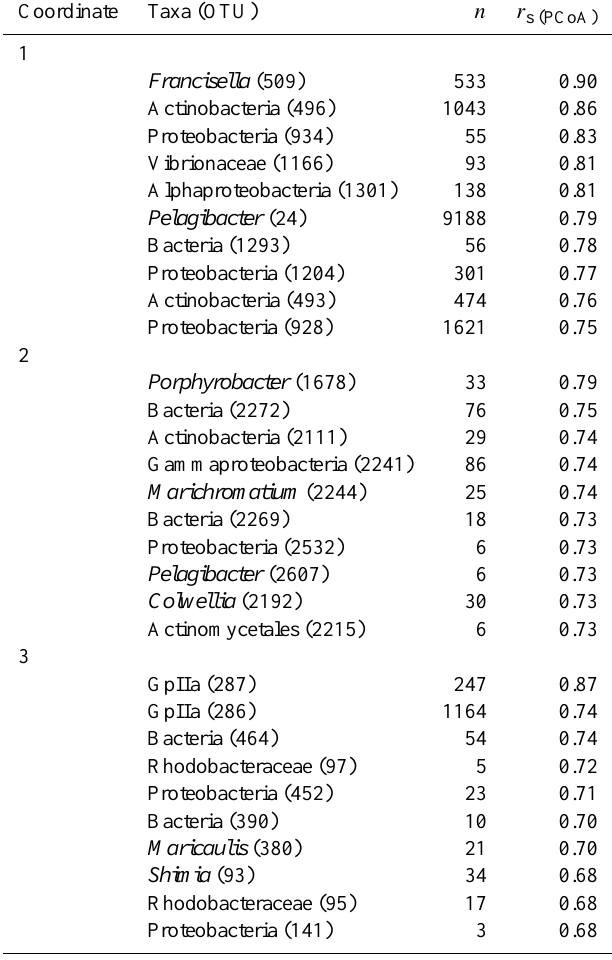
Table 4. Top 10 correlated (Spearman, r s ) OTUs with principal coordinate analysis (PCoA) ordination. Counts ( n ) are normalized read abundance and an OTU numerical identifier is shown in paren- theses to differentiate OTUs with identical taxonomic labels.